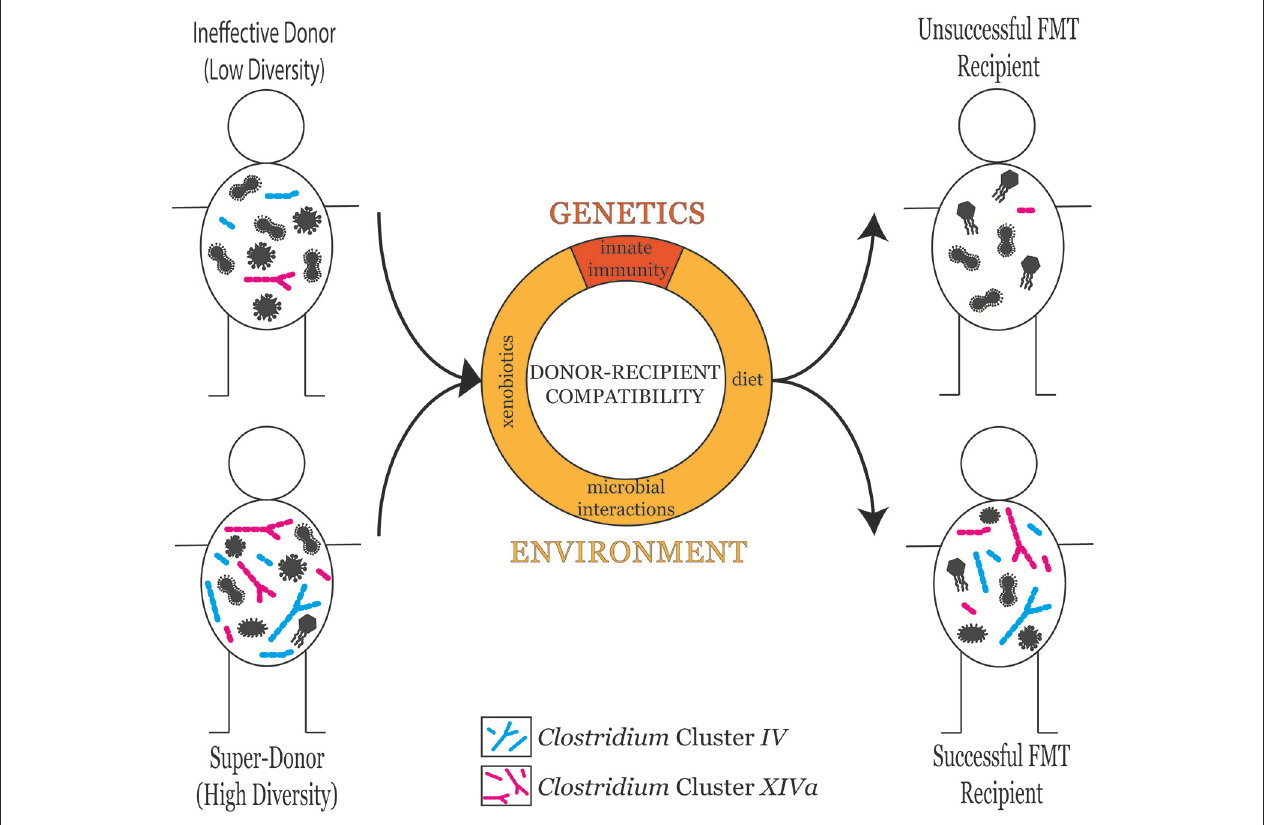
FIGURE 1 | The microbial diversity of the donor is a good predictor of FMT success in the recipient. However, donor-recipient compatibility also plays an influential role in determining FMT success. Donor-recipient compatibility can stem from genetic factors such as differences in innate immune responses, or environmental factors including diet, xenobiotic exposure, and microbial